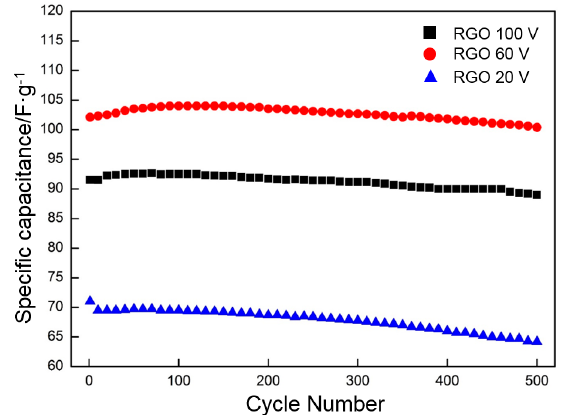
Figure 17. Cycling test for RGO (deposited at different deposition voltages and reduced at 300 °C) at a scan rate of 0.05 V·s − 1 up to 500 cycles.